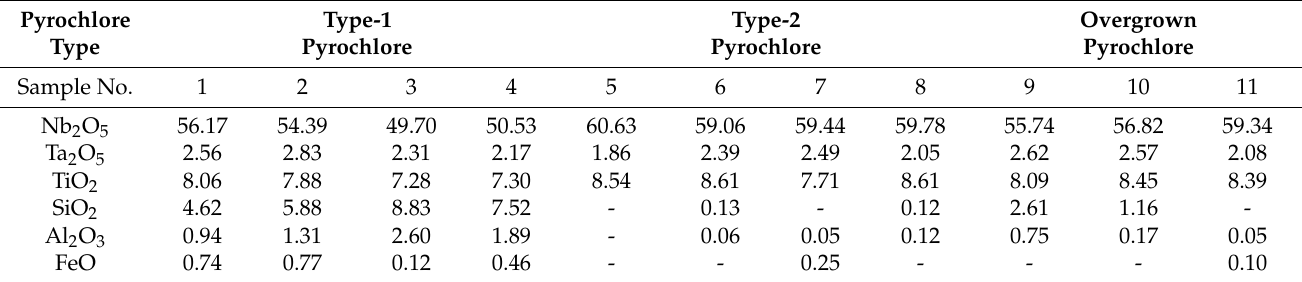
Type-2 Pyrochlore